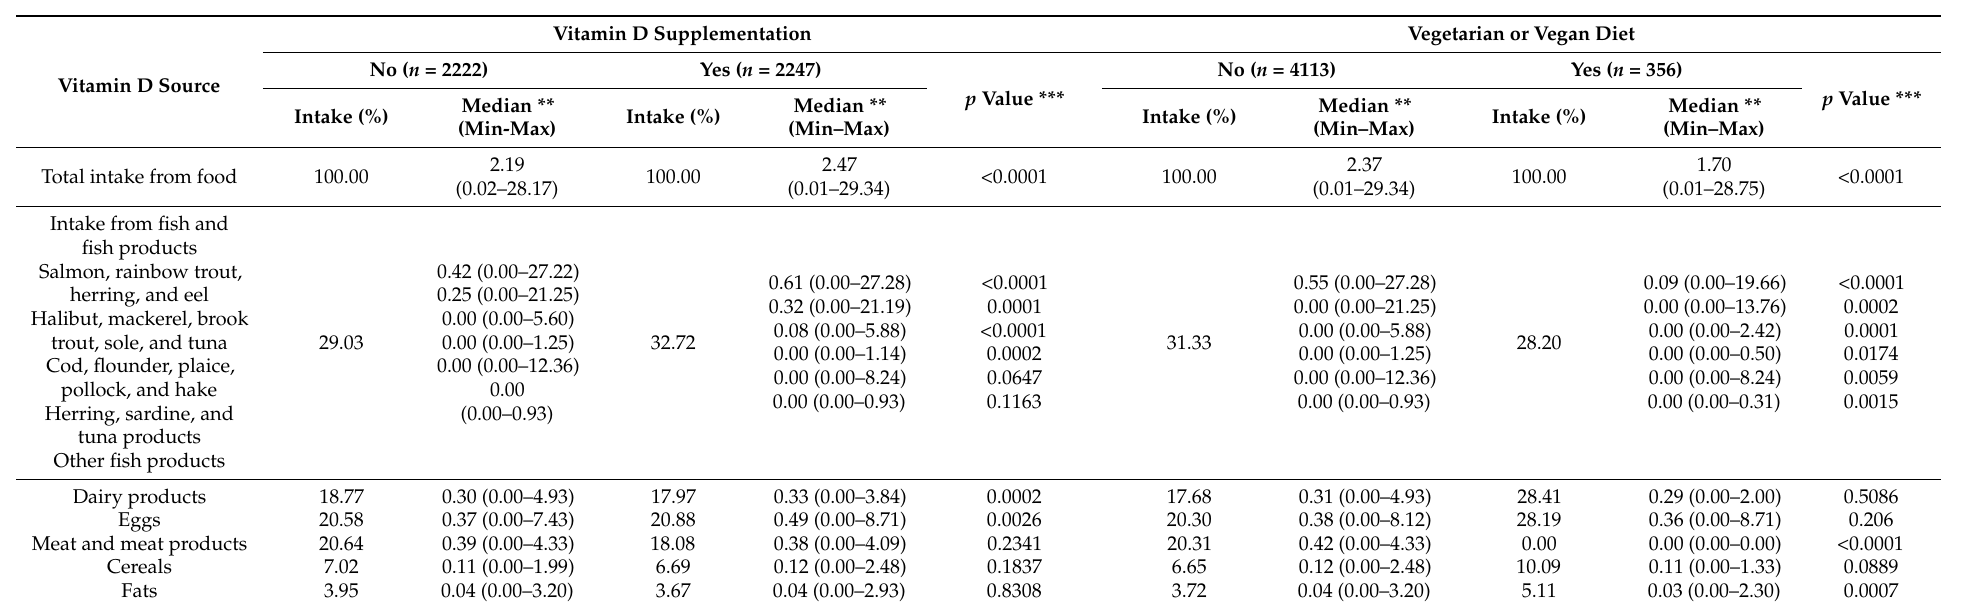
Table 7. Comparison of vitamin D intake from various food groups ( µ g per day) in the subgroups of female post-primary school students not supplementing and supplementing vitamin D, and following omnivorous vs. vegetarian or vegan